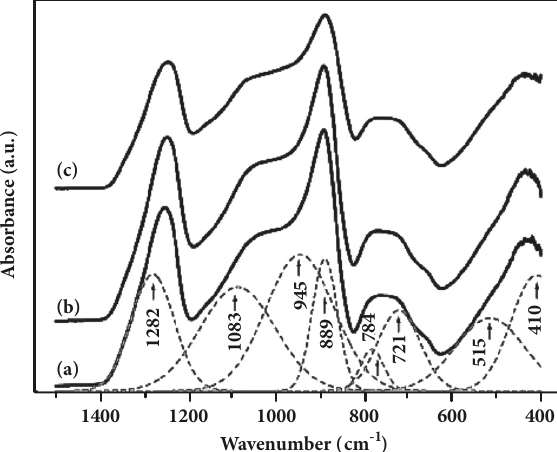
Figure 11: FT-infrared absorption spectra of (a) 0.25% CeO 2 + 0.25% Sm 2 O 3 , (b) 1% CeO 2 + 1% Sm 2 O 3 , and (c) 2.5% CeO 2 + 2.5% Sm 2 O 3 - doped